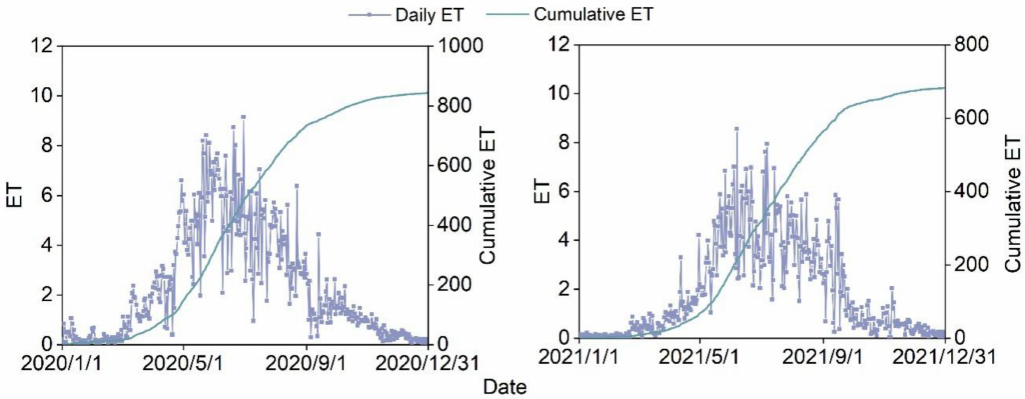
Figure 4. Variations of evapotranspiration (ET) and cumulative ET in 2020 and 2021.